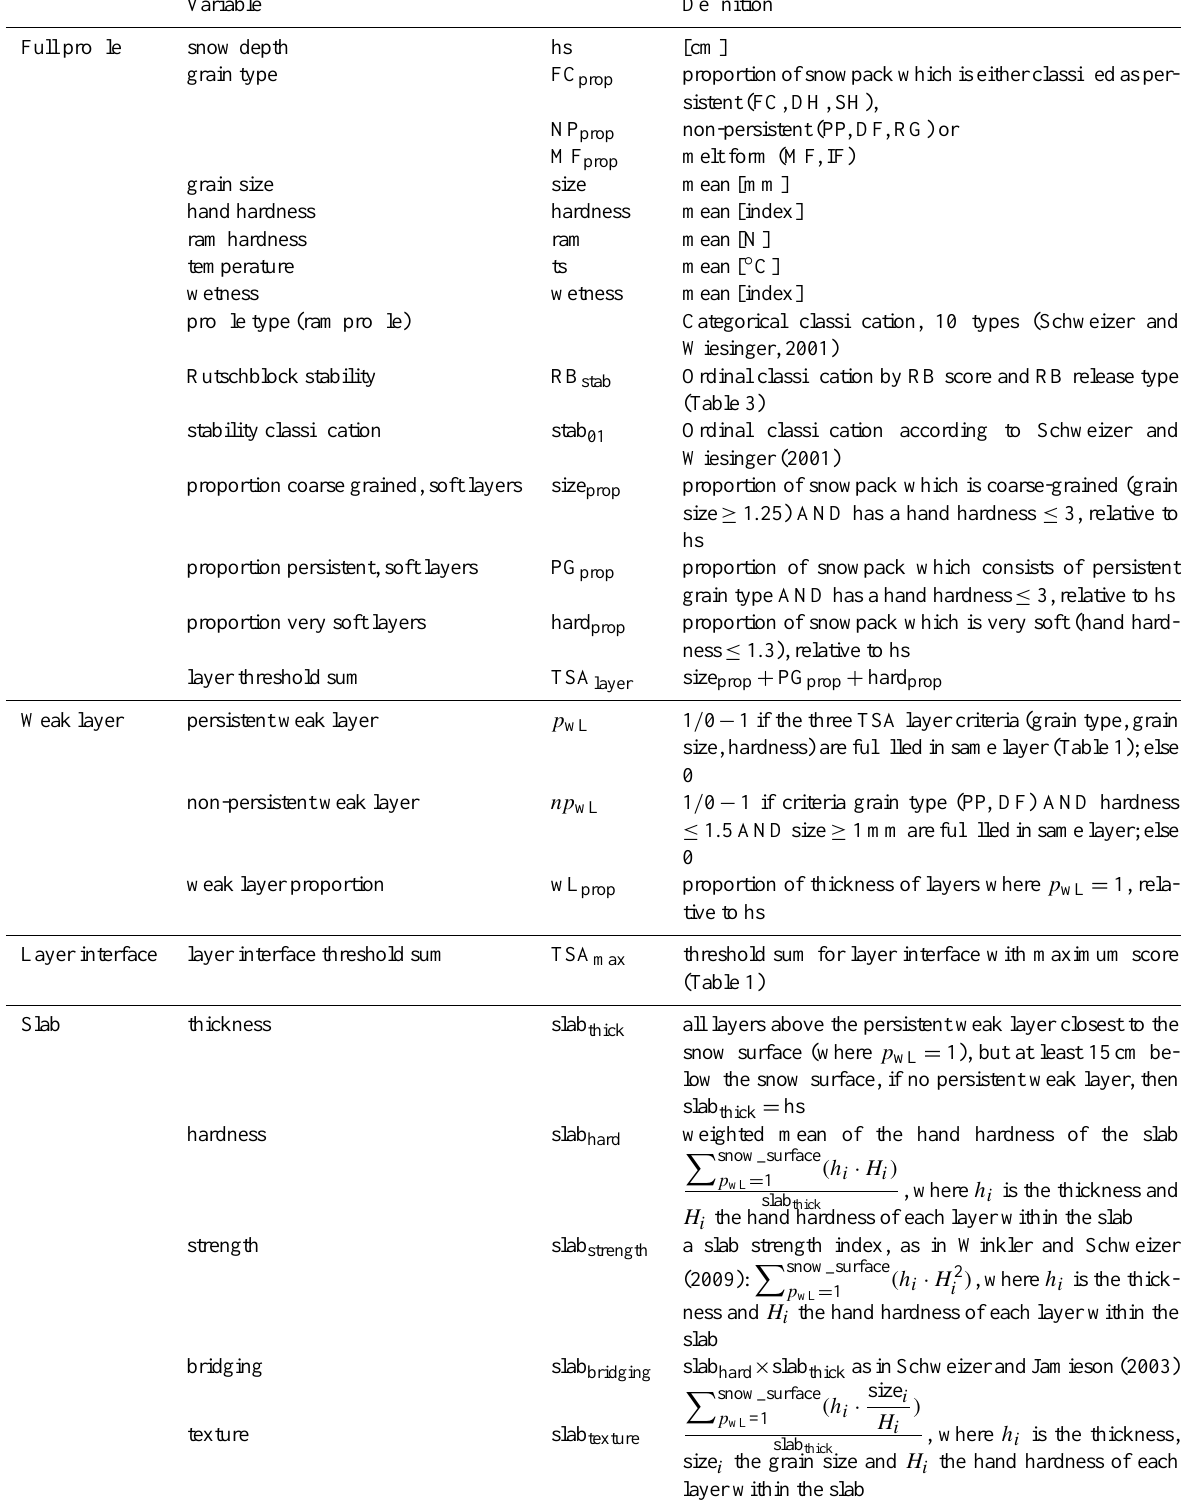
Table 2. Selection of some of the most important, investigated snowpack